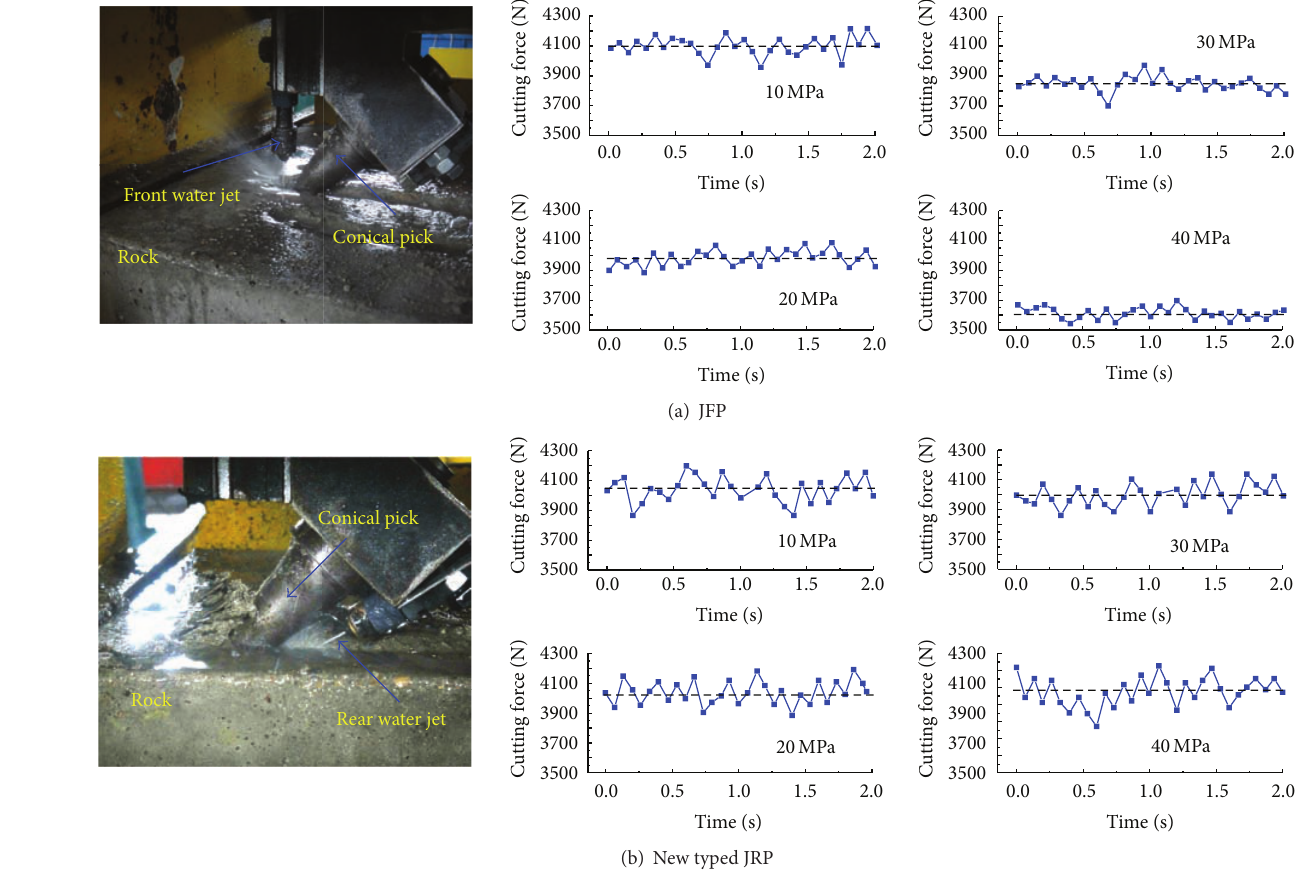
Figure 7: Photos of cutting experiment for JFP and new typed JRP.